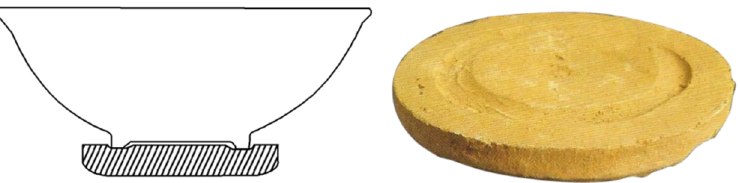
Figure 7. Cushion cake samples unearthed from Xiaopi kiln ceramics and drawing of upside-down firing.